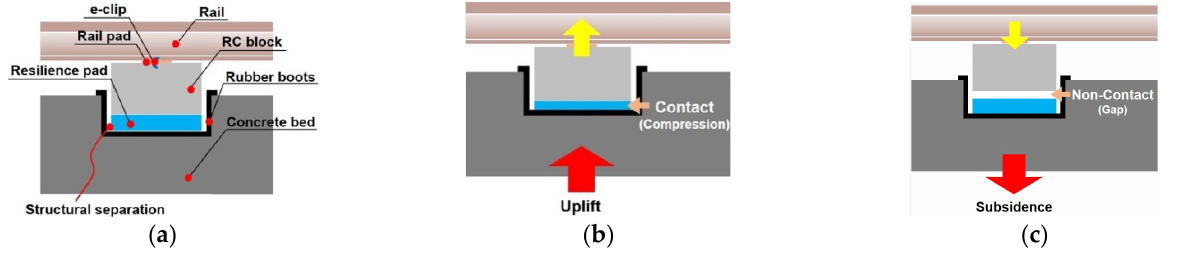
Figure 2. Interaction between the booted sleeper track (STEDEF) and substructure under the ( a ) general condition; ( b ) uplift condition; and ( c ) subsidence condition.